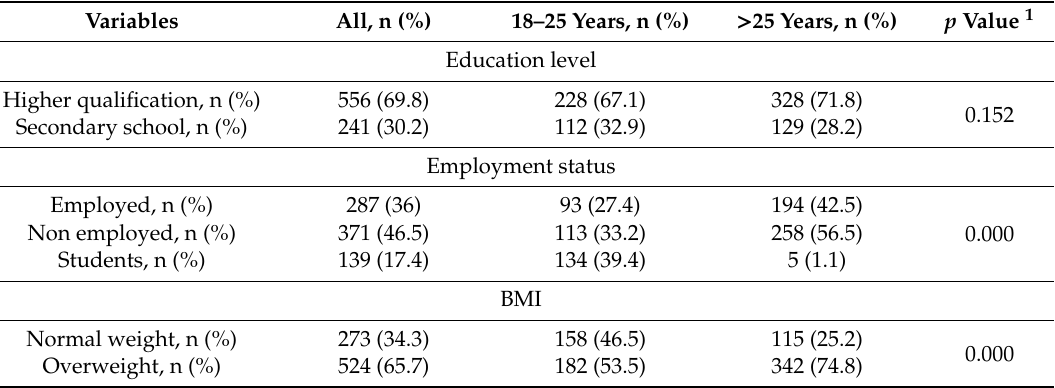
Table 1. Sociodemographic characteristics of the